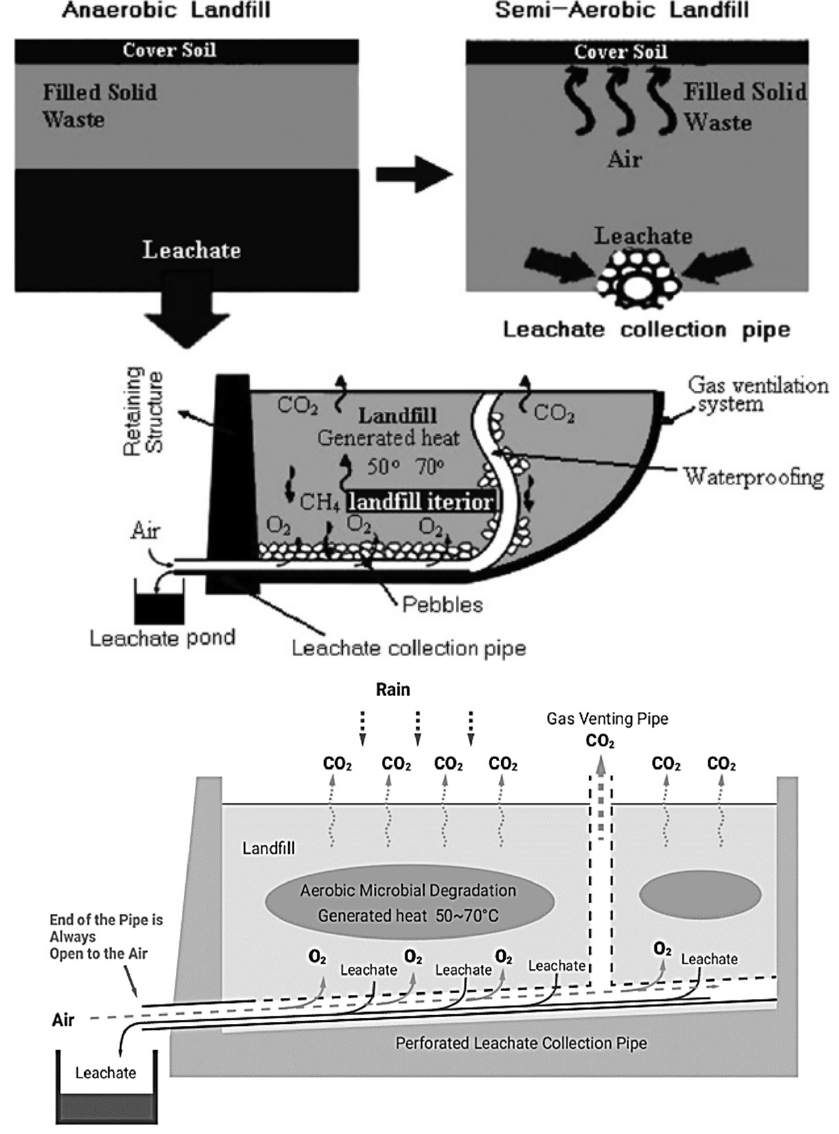
Figure 1. Conceptual landfill design using a semi-aerobic concept [11].